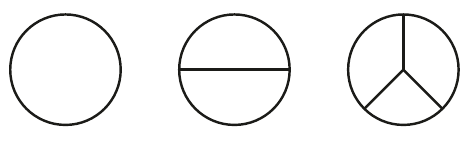
Figure 1 . Most UV divergent one-, two- and three-loop vacuum